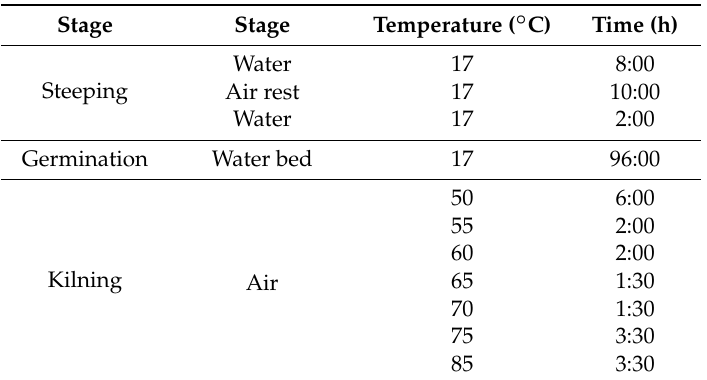
Table 8. Joe White Malting Systems Newmalt micromalter standard